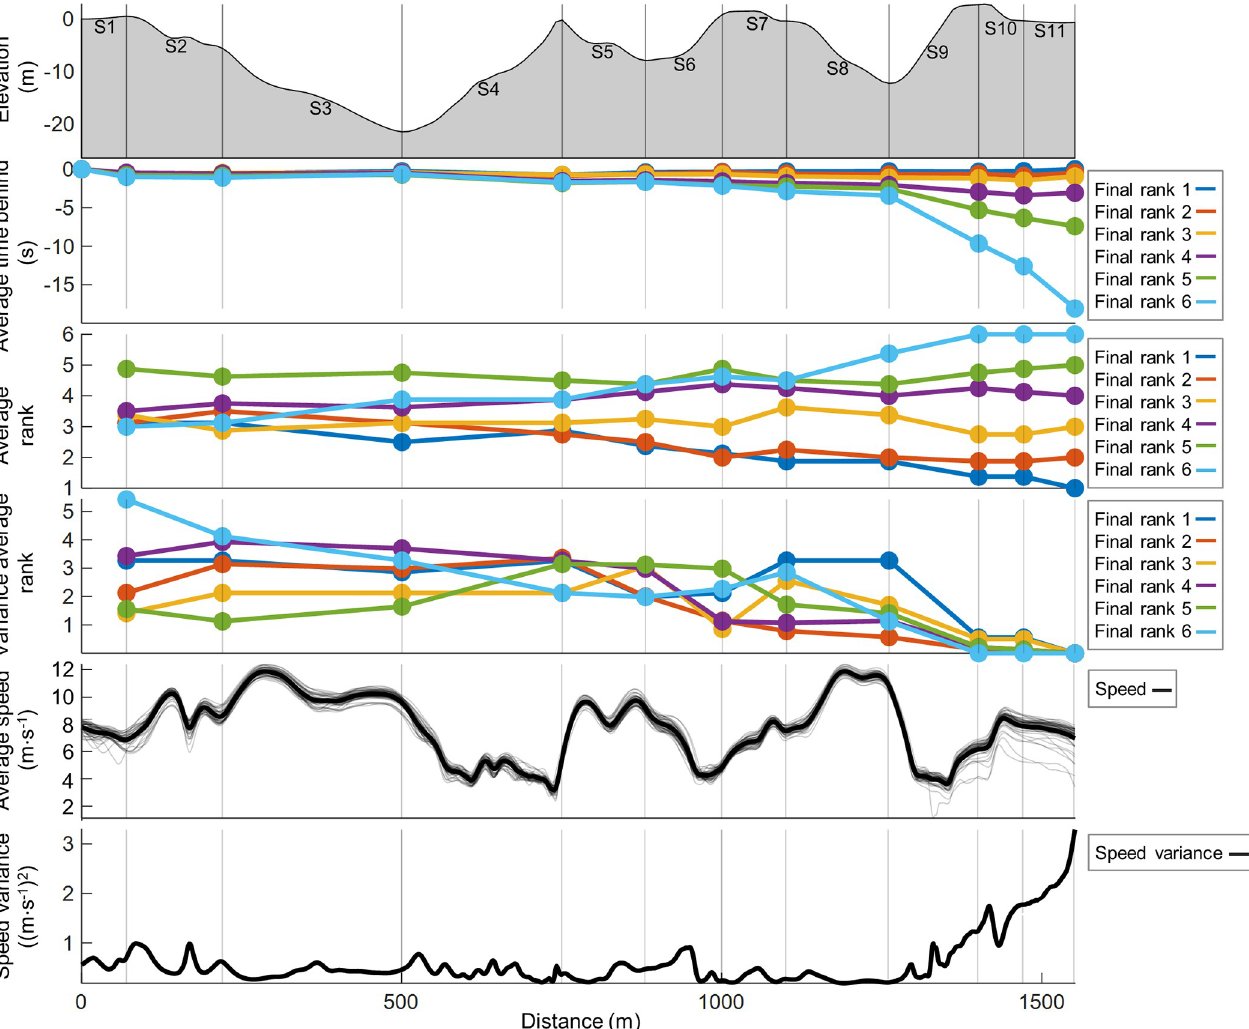
Fig 3. Time behind, speed, and positioning. The average time behind the winner, intermediate rankings, and skiing speed across the racecourse in 11 segments (S1-S11) during the heats of a classical sprint cross-country skiing race for elite male skiers [N = 29 time and speed, N = 30 positioning].